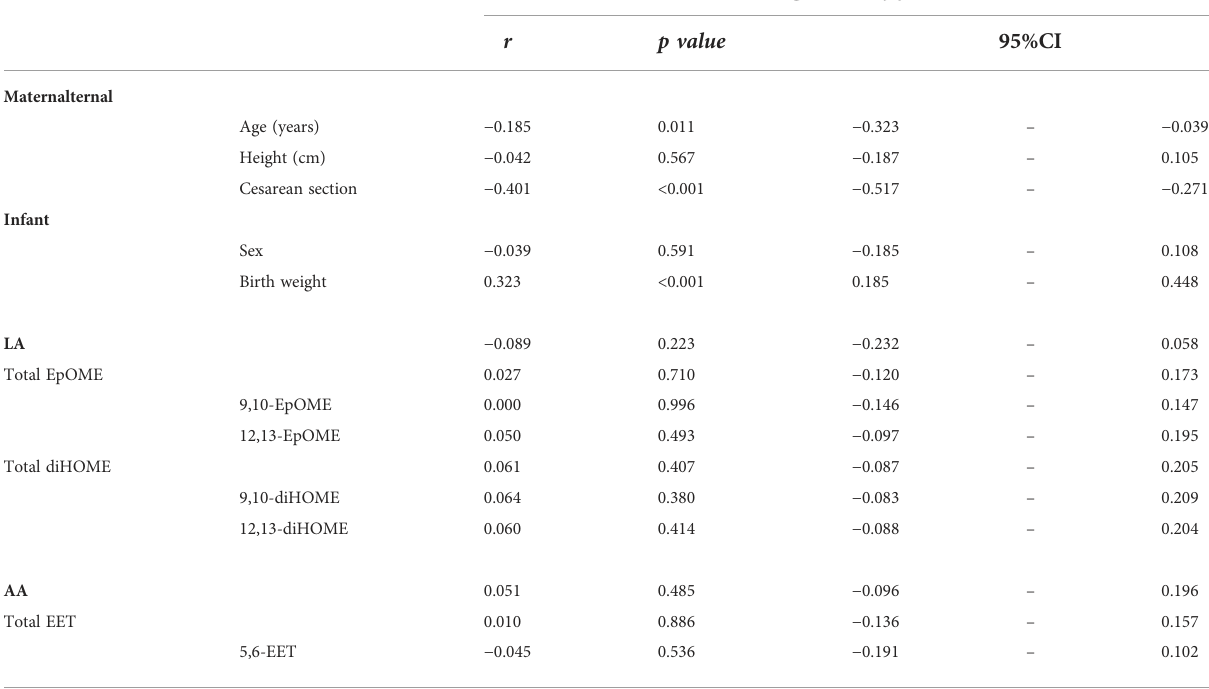
TABLE 5 Correlation between gestational age and PUFA metabolite in cord